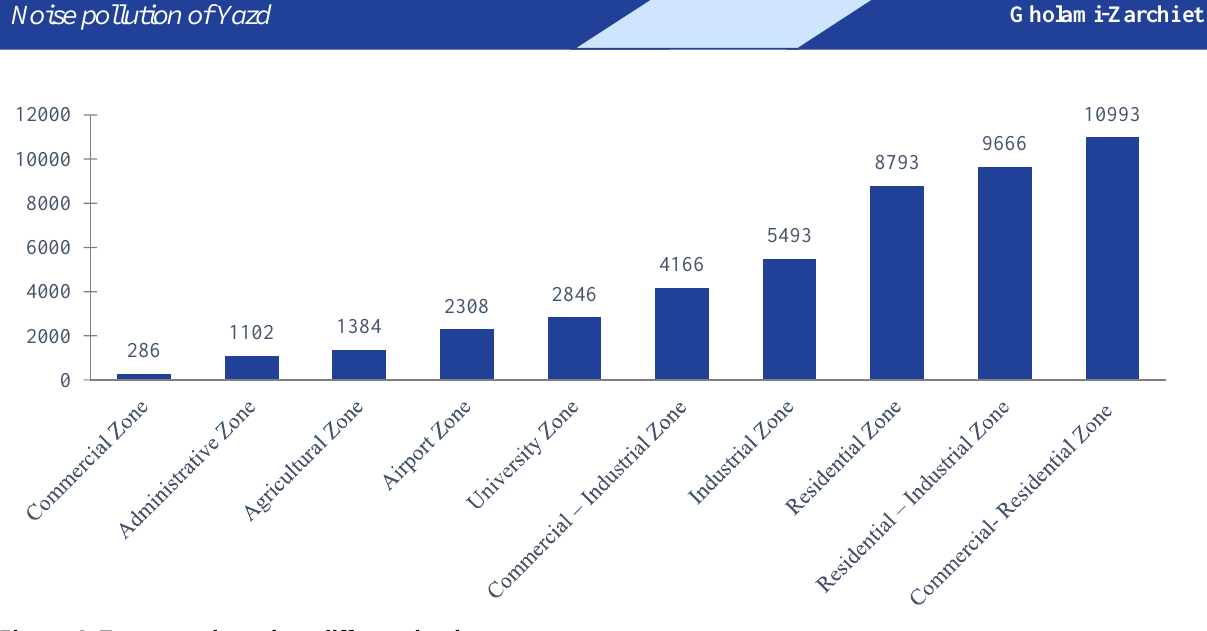
Figure 4. Zone area based on different land uses Table 3. Sound pressure level (SPL) (dB) range of each zone area (ha) SPL (dB) range